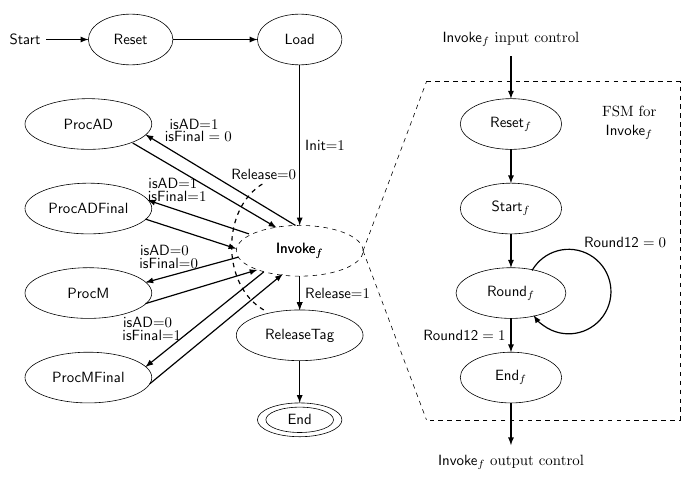
Figure 4: Finite State